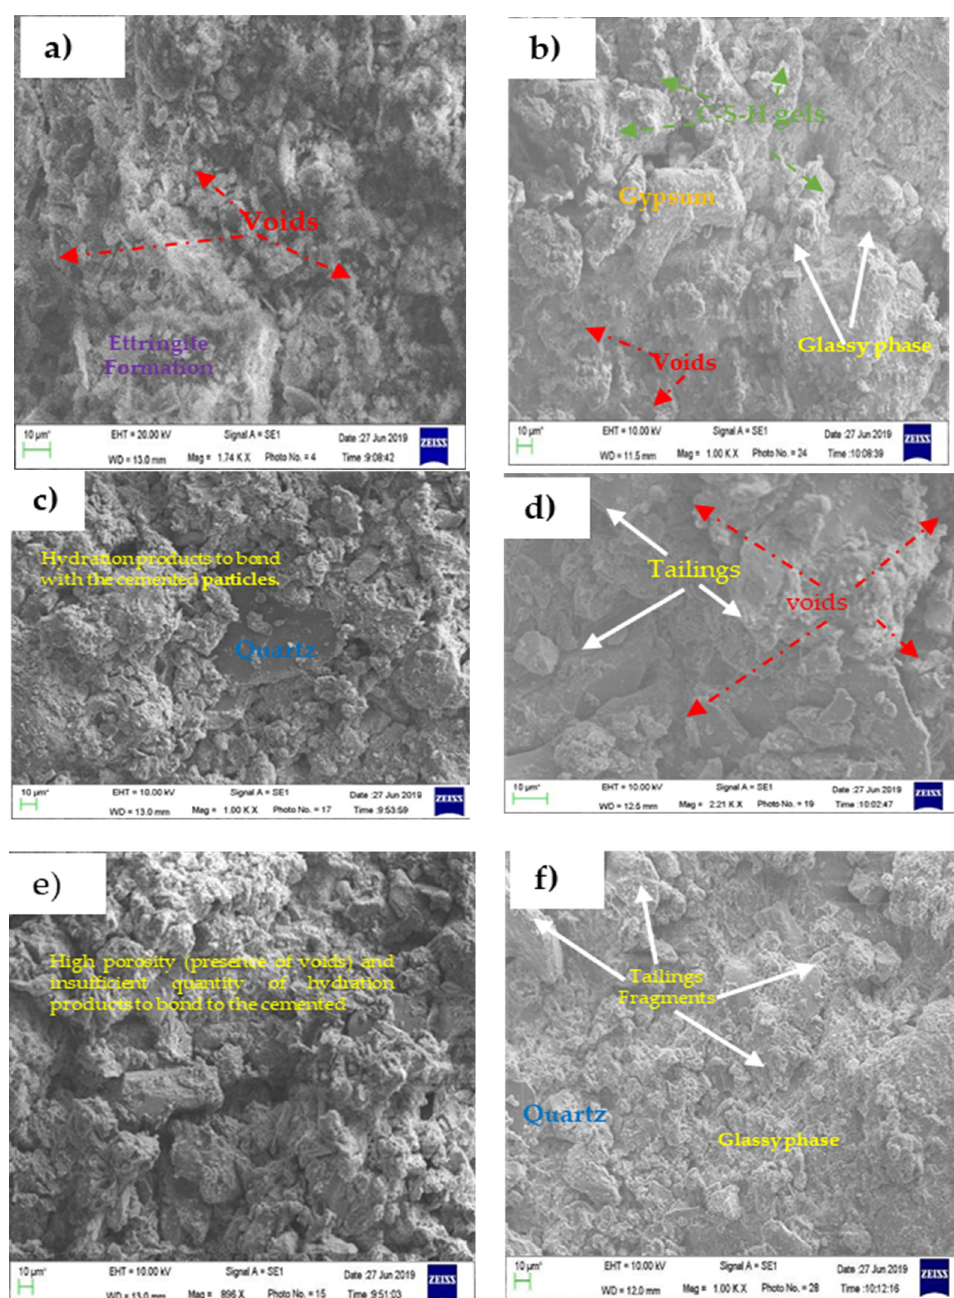
Figure 7. Microstructure properties of CWTB at solids content 75 wt. % as a function of curing time ( a , b ) 14, ( c , d ) 28 and ( e , f ) 42 days at different binders’ dosage.